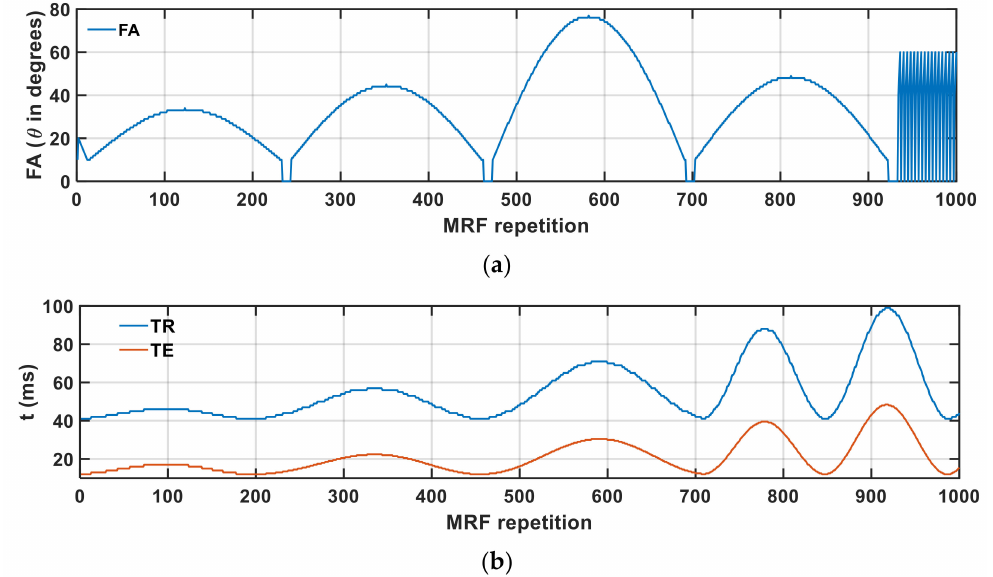
Figure 1. Shown are pseudo-randomised pattern of ( a ) flip angles (FA) and ( b ) the repetition time (TR) in blue and echo time (TE) in red used to acquire the 3D MRI data for each MRF